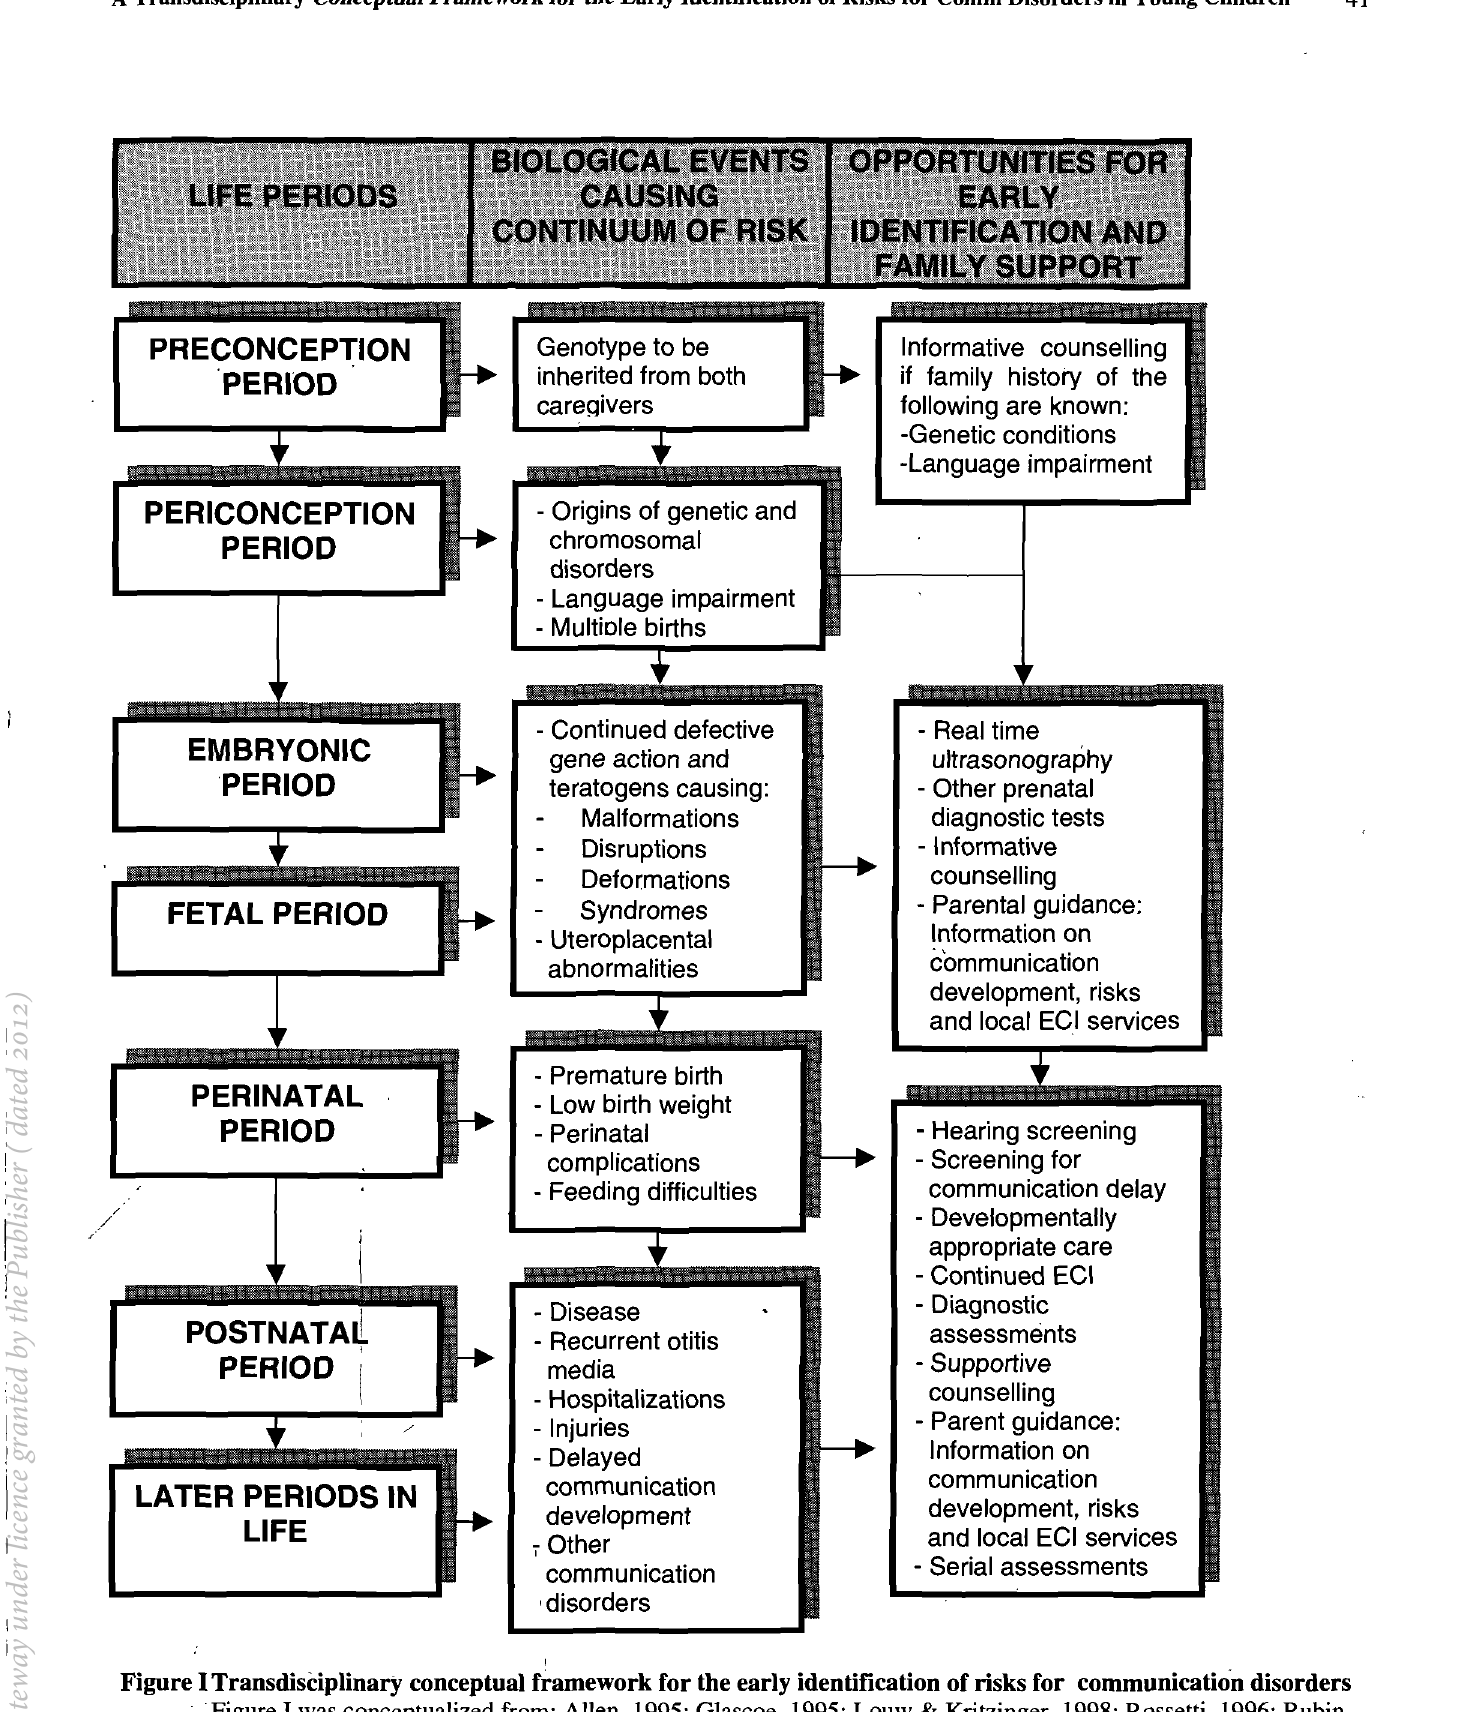
Figure I TransdisCiplinary conceptual framework for the early identification of risks for communicatio'n disorders Figure I was conceptualized from: Allen, 1995; Glascoe, 1995; Louw & Kritzinger, 1998; Rossetti, 1996; Rubin,